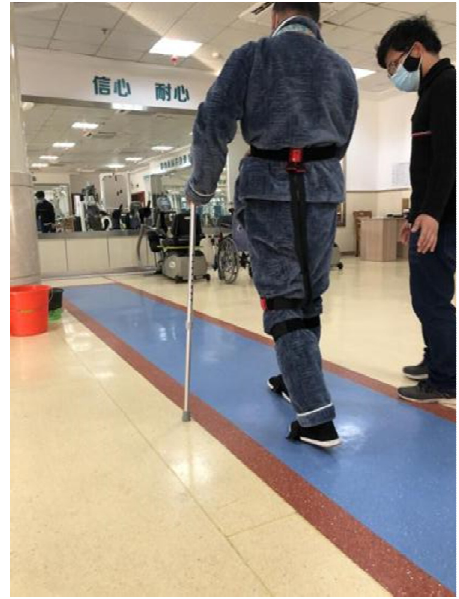
Figure 1. Gait experiments of stroke patients.